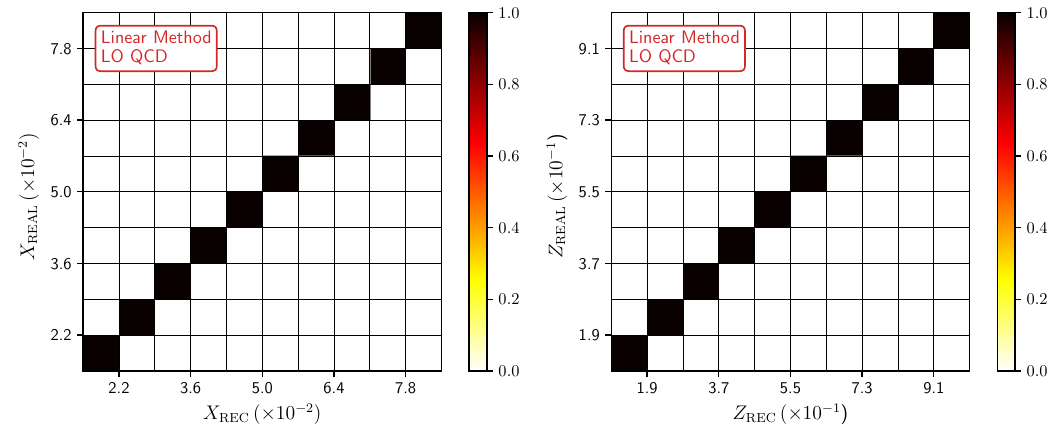
and Z ) REAL REAL